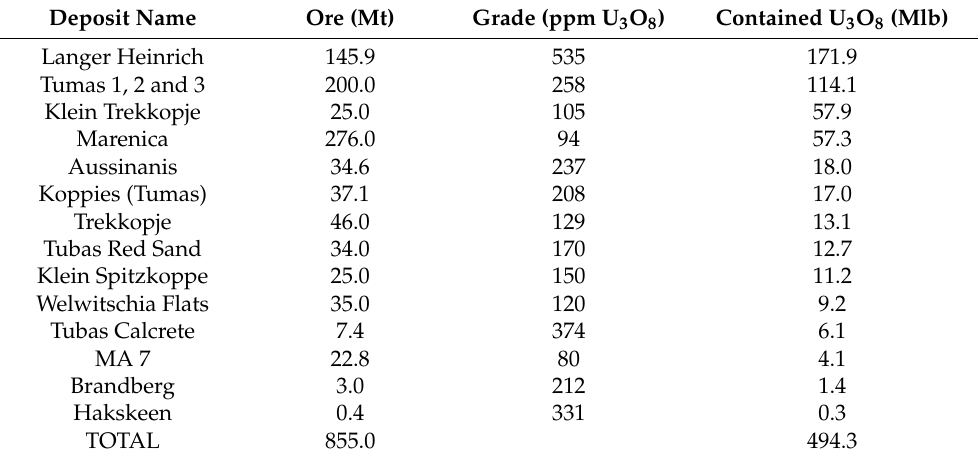
Table 1. Uranium resources of palaeochannel type deposits in the Erongo region of Namibia